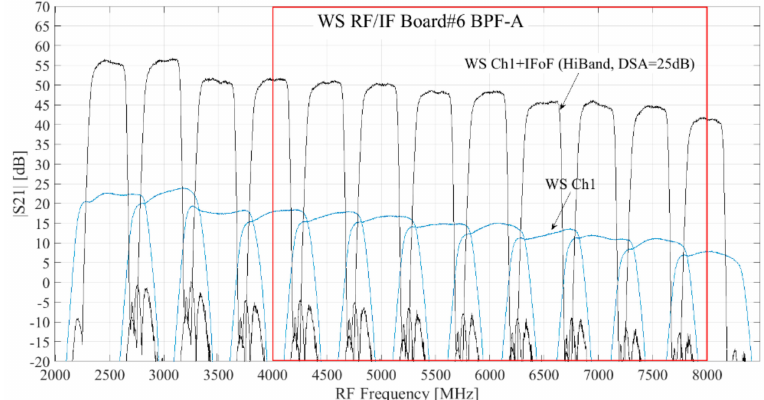
Figure 23. Measured gain of board #6 for 12 di ff erent LO frequency settings, from 3 GHz to 8.5 GHz by 0.5 GHz steps: including IFoF link with DSA = 25 dB (black curves) and without IFoF link (blue curves). The vertical red lines at 4 and 8 GHz delimit the nominal band edges of